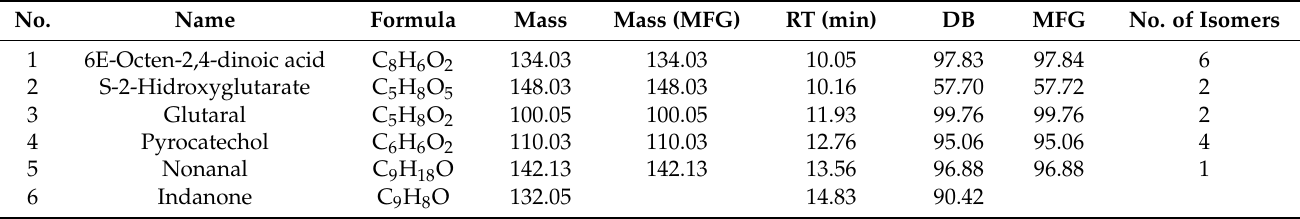
Table 2. Main compounds in the 11th and 12th fractions of the chloroformic extract of aerial parts of Salvia connivens . No.